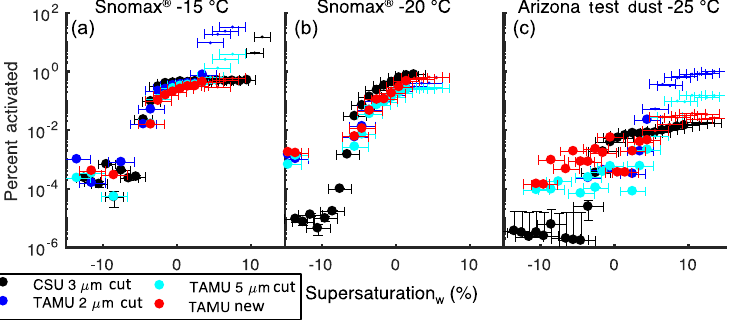
Figure 11. TAMU CFDC versus CSU CFDC comparison: (a) Snomax ® at − 15 ◦ C, (b) Snomax ® at − 20 ◦ C, and (c) Arizona test dust at − 25 ◦ C. Small symbols indicate that those points were sampled in WDBT. TAMU 2µm cut and 5µm cut traditional activated INP fraction are shown in blue and cyan, respectively. The TAMU new analysis method activated INP fraction is shown in red. The CSU 3µm INP fraction activated is shown in